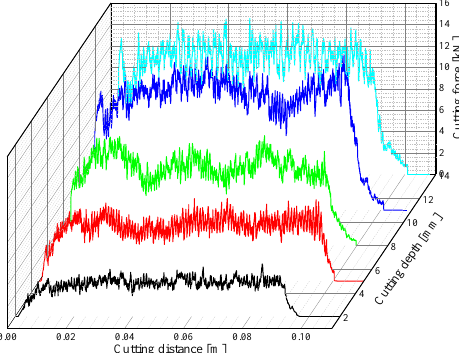
Figure 13. The cutting force curves with the different cutting depths.